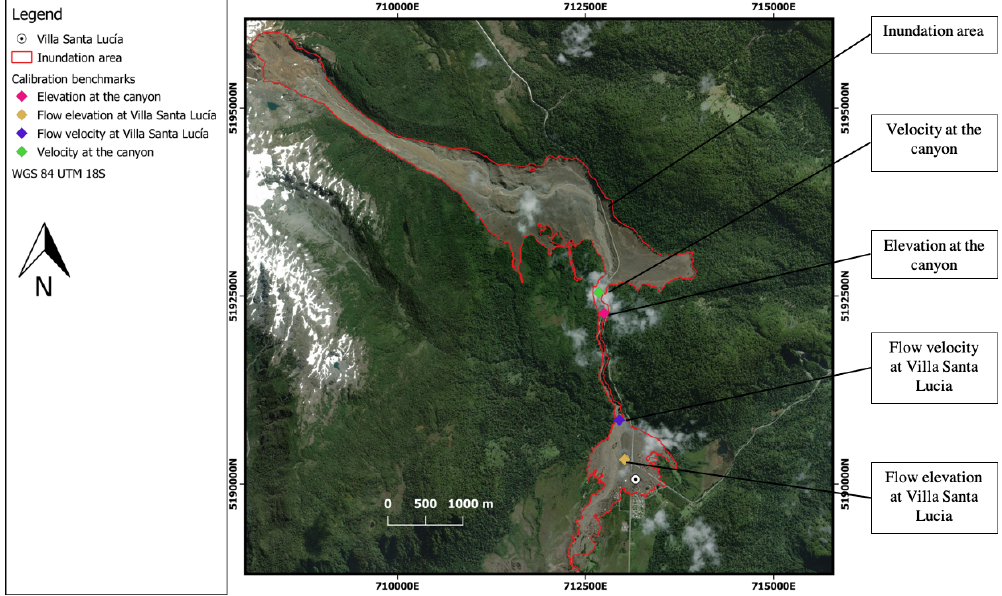
Figure 7. Location of the parameter estimation for the calibration of the models (background © ESRI). Table 4. Initial parameters for the r.avaflow